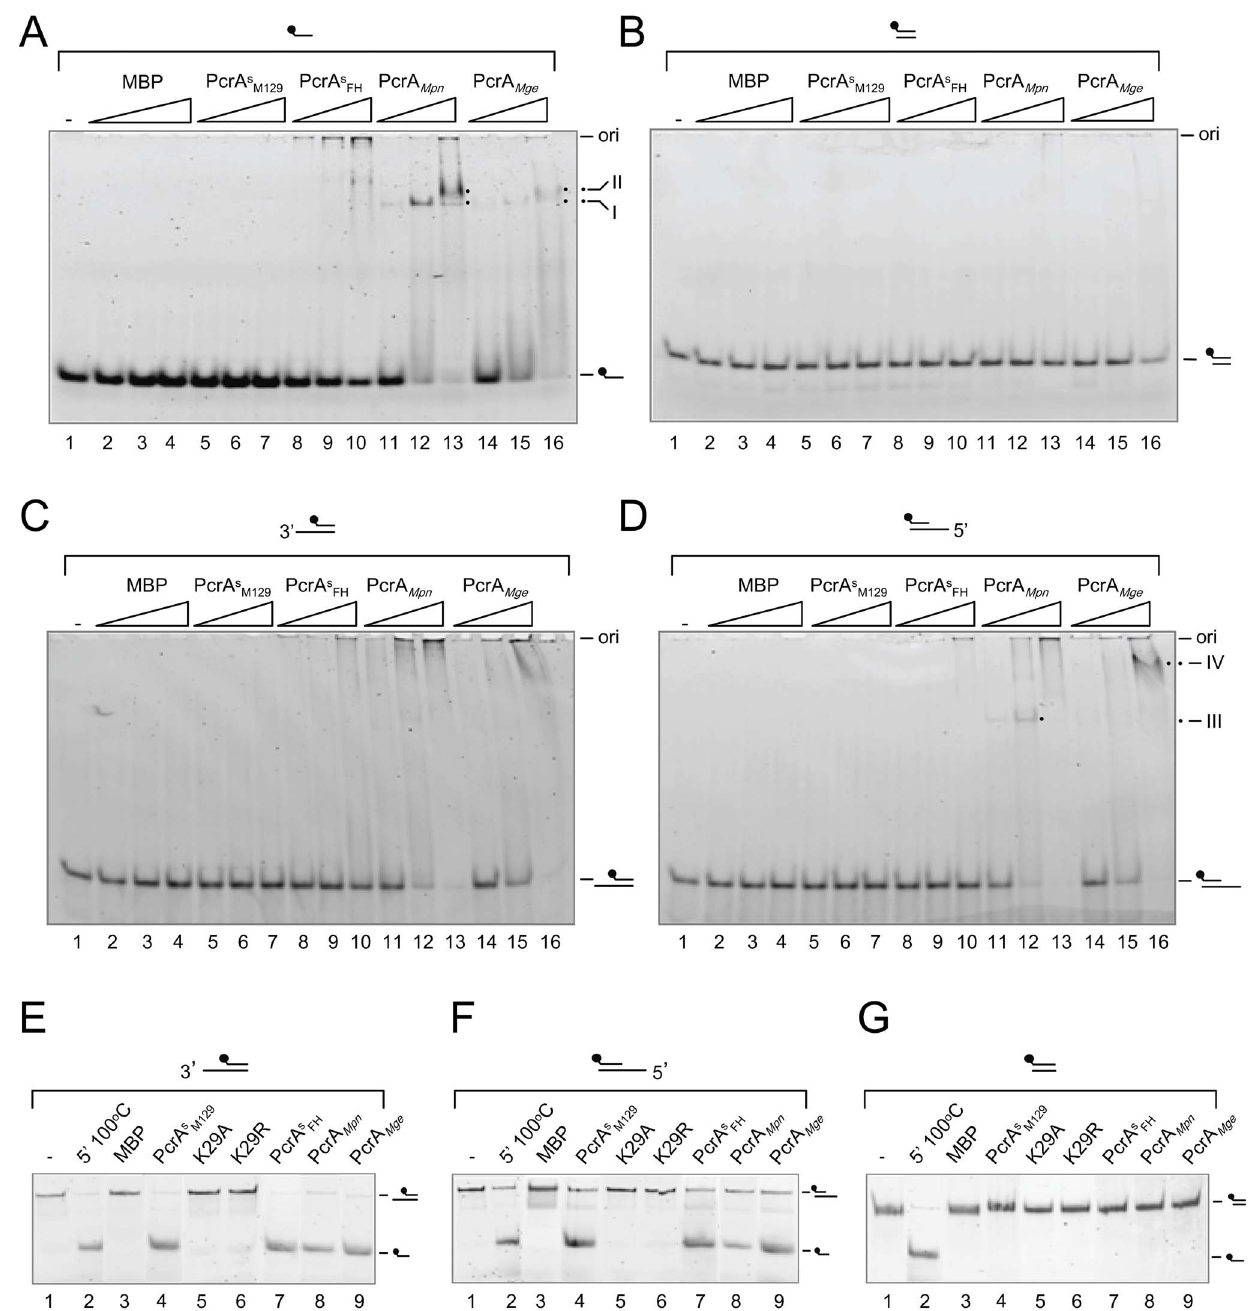
Figure 3. DNA-binding and DNA helicase activities of the PcrA proteins from M.pneumoniae and M.genitalium . (A) Binding of the PcrA proteins to 6-FAM-labeled oligonucleotide 1 was tested by EMSA. The PcrA proteins, as well as control protein MBP, were tested at 22 nM, 67 nM and 200 nM, respectively, as indicated from left to right by the triangles above the lanes. Protein was omitted from the reaction shown in lane 1 (‘ 2 ’). The positions of the free substrate and the position of protein-DNA complexes (I and II) are indicated at the right-hand side of the gel. Complex I and II are also pointed out by dots next to lanes 13 and 16. ‘ori’ indicates the origin of the gels. (B) Binding of the PcrA proteins and MBP to ds, blunt-ended substrate ‘c’. The experiment was performed similarly as described in (A). (C) Binding of the PcrA proteins and MBP to partially ds substrate ‘a’ (which contains a 3 9 24-nt ss extension). The experiment was executed similarly as described in (A). (D) Binding of the PcrA proteins and MBP to partially ds substrate ‘b’ (which contains a 5 9 24-nt ss extension). The experiment was done in a similar fashion as described in (A). (E) DNA helicase activity of the PcrA proteins on substrate ‘a’. The DNA helicase reactions were performed as described in Materials and Methods. Reactions were carried out in volumes of 10 m l and contained DNA substrate ‘a’ (at 4 nM) and either 0 nM (marked ‘ 2 ’, lane 1) or 50 nM of protein (as indicated above the lanes). After the reaction, the samples were deproteinized, electrophoresed through a native 12% polyacrylamide gel, and analyzed by fluorometry. The positions of the substrate and reaction products are indicated at the right-hand side of the gel. (F) DNA helicase activity of the PcrA proteins on substrate ‘b’. The experiment was done in a similar way as in (E). (G) DNA helicase activity of the PcrA proteins on substrate ‘c’. The experiment was performed as described in (E).